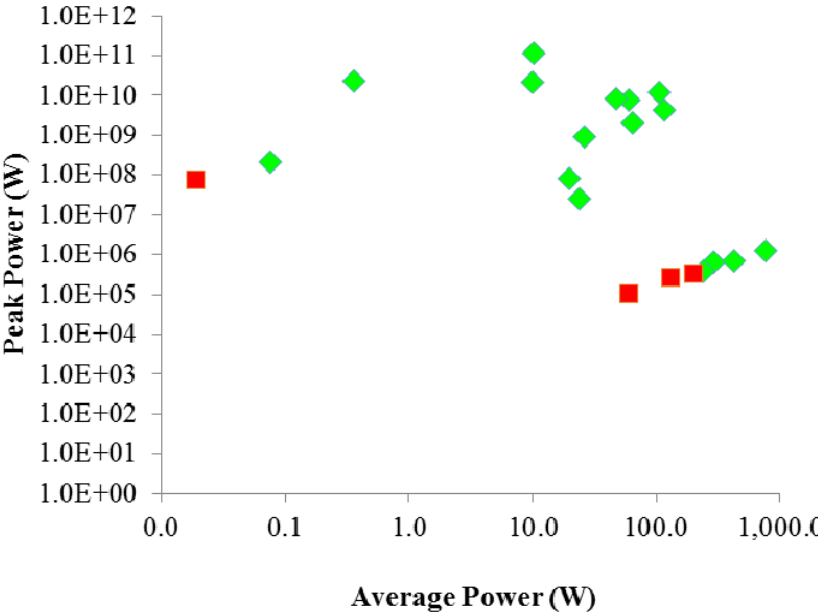
Figure 48. Yb:YAG, Yb:YLF, and Yb:YAG+Yb:GSAG compressed or direct peak power for fundamental (green) and second-harmonic (red) wavelengths, as a function of average power. Numerical values and references are taken from Table 10.